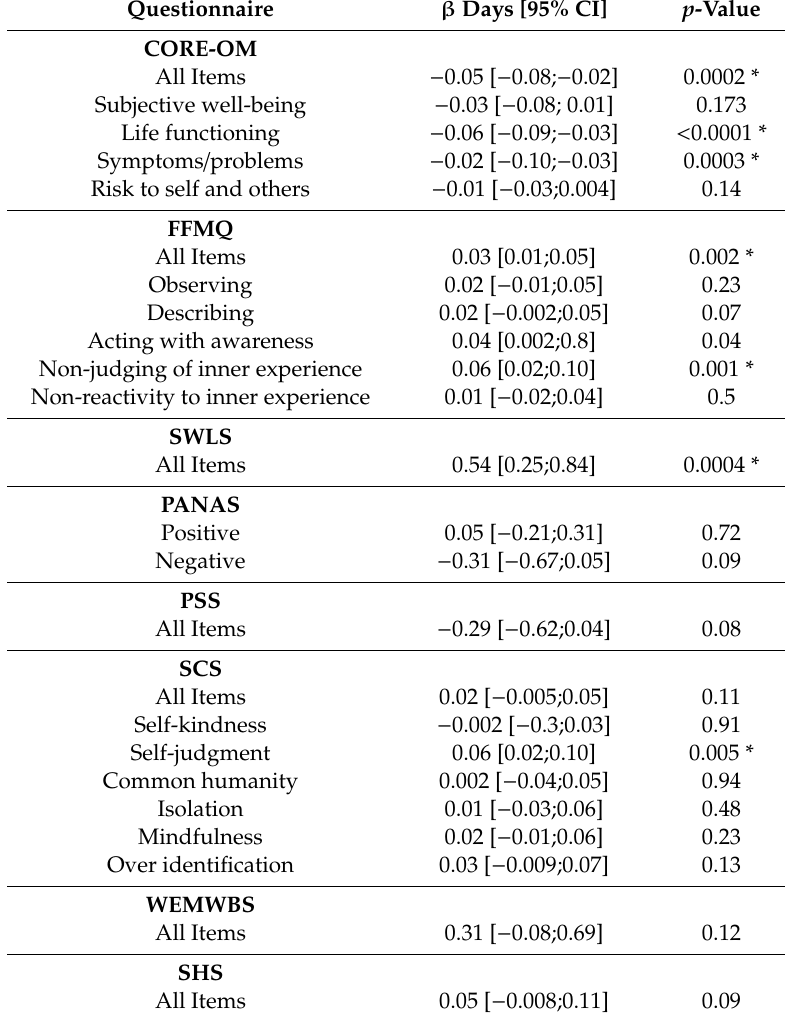
Table 4. Linear model for the e ff ect of the number of meditation sessions attended in the treatment group on each questionnaire and subscale (pre-post di ff erence). β coe ffi cient of days of meditation ( β days) with its 95% CI, and p -value are